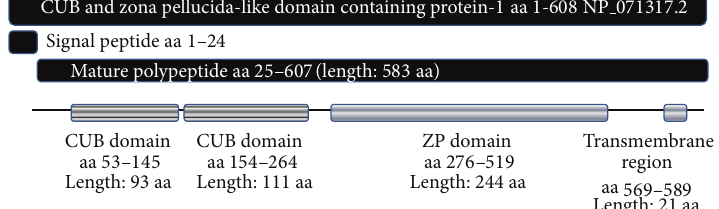
Figure 2: CUZD1 protein features including the CUB and ZP domain exact positioning within the